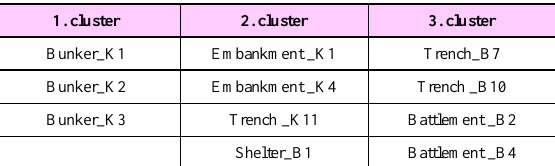
Table 3. Subjective classification of features of general shapes according to strong indicators of mine presence in three clusters.